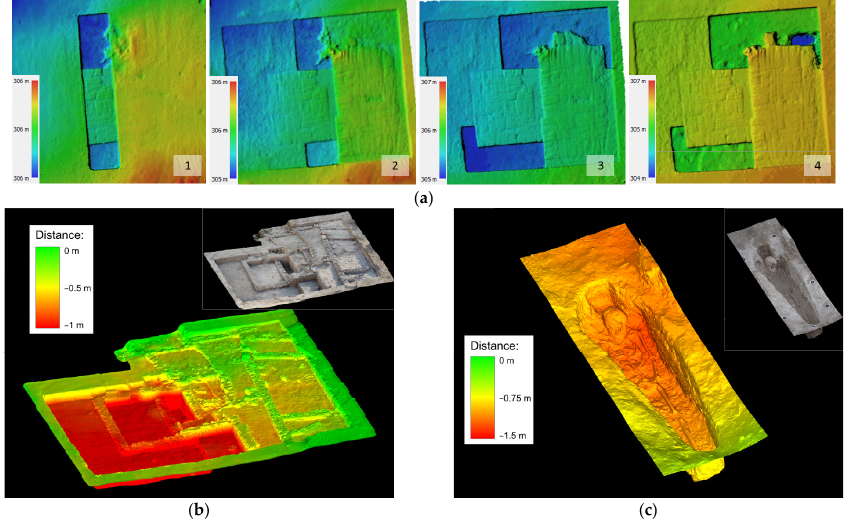
Figure 7. Examples of the modelling of archaeological work developed considering two scale levels: ( a ) representation of four DEMs of a test excavation; ( b ) distances between 3D models in test excavation; ( c ) distances between 3D models in a burial.